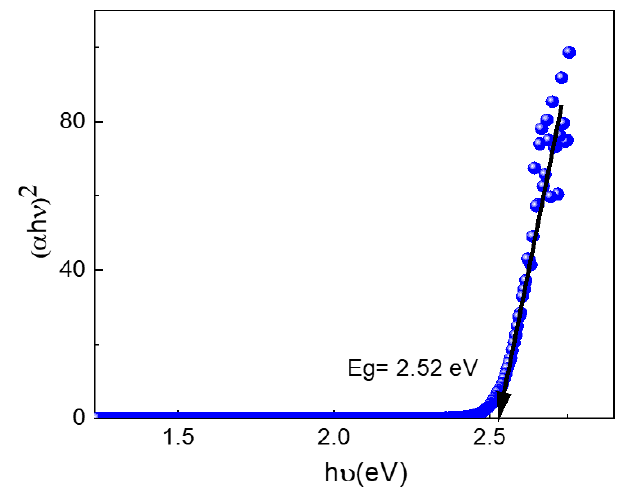
Figure 5. Direct optical transition of Ag 3 PO 4 .